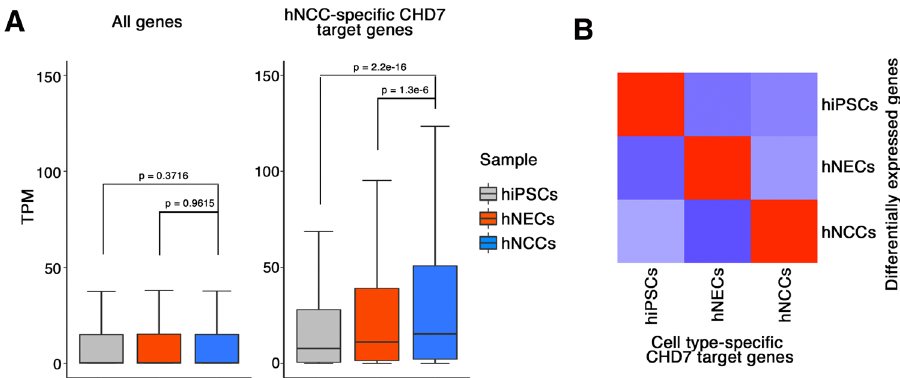
Figure 4. Correlation of CHD7-bound enhancer regions with transcription of target genes in hNCCs. ( A ) Boxplot showing expression of all genes (left) and hNCC-specific CHD7-target genes (right) in hiPSCs, hNECs, and hNCCs. ( B ) Correlation analysis of cell type-specific CHD7 target genes and DEGs in hiPSCs, hNECs, and hNCCs. Heatmap showing z-score of